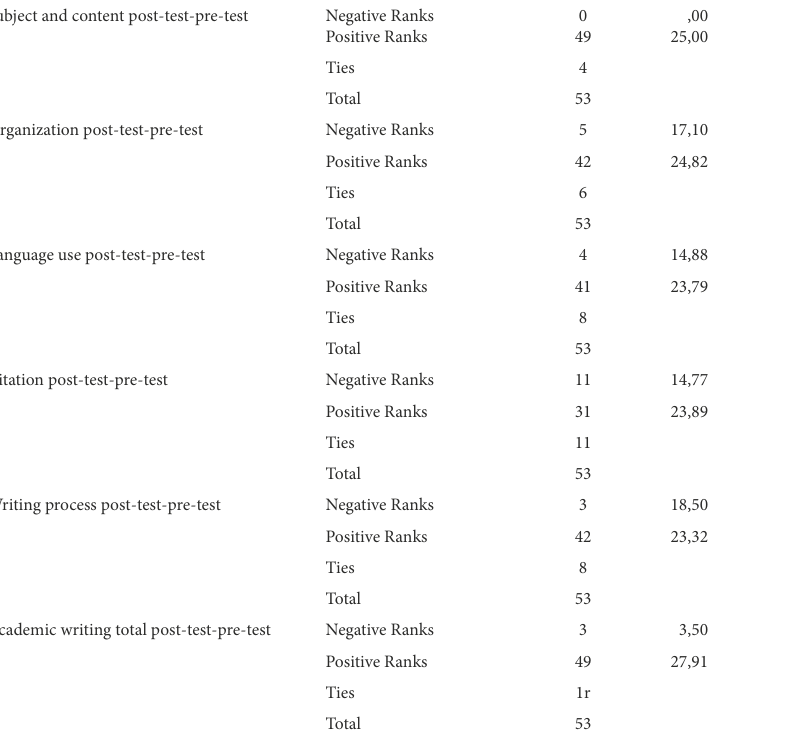
TABLE 6 Wilcoxon Signed Ranks Test